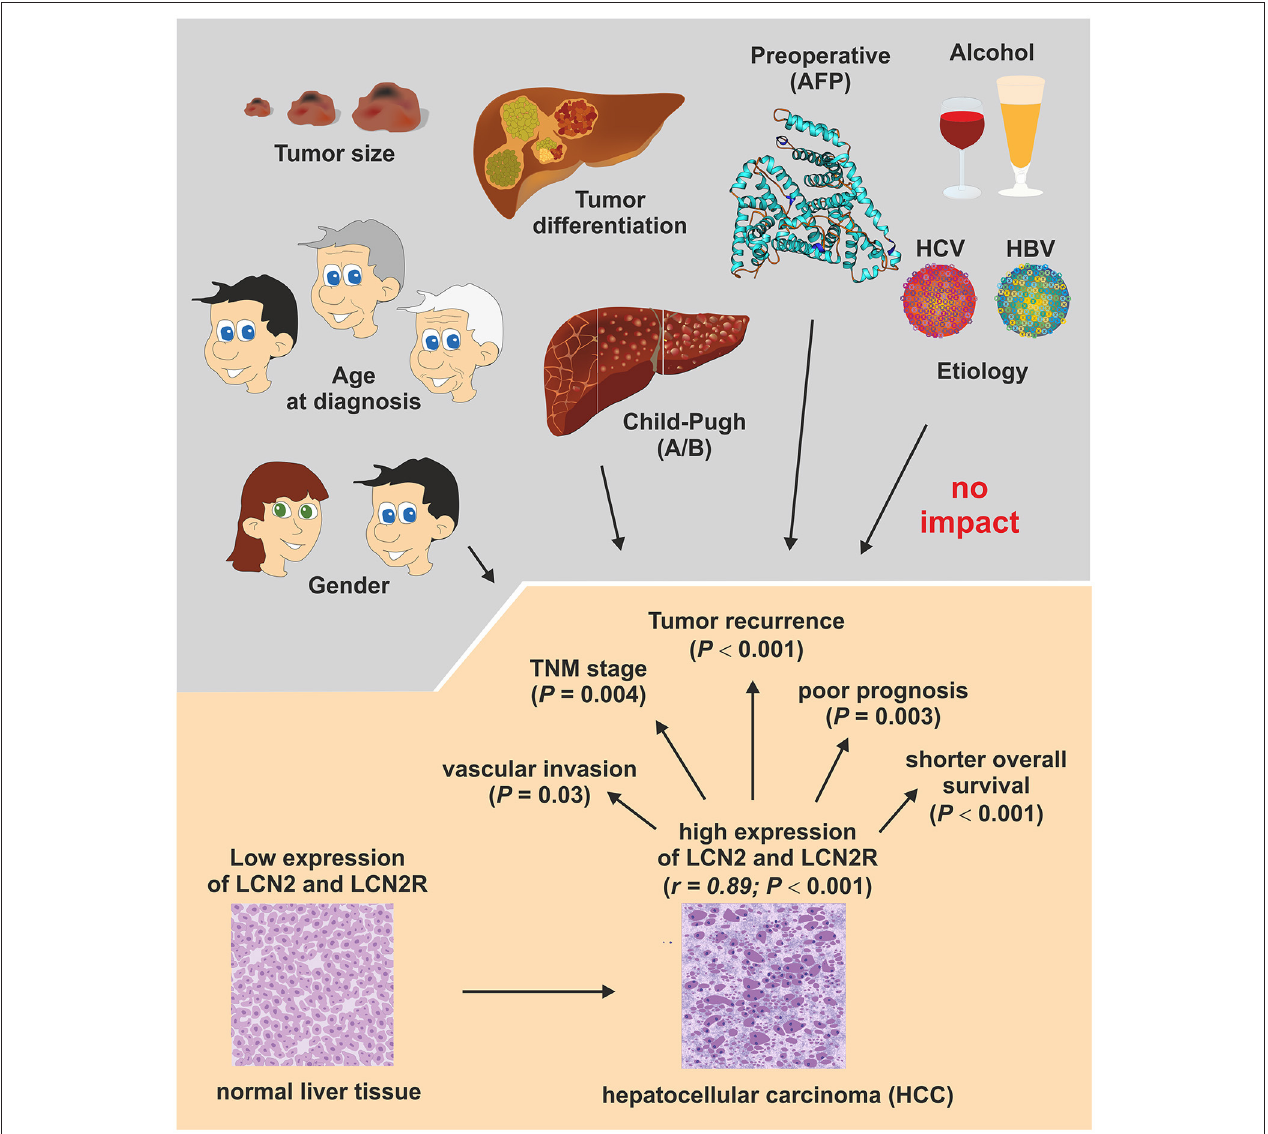
FIGURE 6 | Association of LCN2 and LCN2R expression with conventional clinicopathological HCC parameters. An association study investigated the clinical significance of LCN2 and LCN2R in 138 patients who underwent curative resection of HCC. In conclusion, this study showed that the expression of both genes is correlated ( r = 0.89; P < 0.001) and are up-regulated in HCC tissue and associated with vascular invasion status ( P = 0.03) and TNM classification stage of malignant tumors ( P = 0.004) that consider characteristics of the original primary tumor (T), the involved regional lymph nodes (N), and the occurrence of distant metastasis (M). In addition, the expression of both genes correlated well with tumor recurrence ( P < 0.001), poor prognosis ( P < 0.003), and overall survival rates ( P < 0.001), suggesting that LCN2 and LCN2R expression are suitable prognostic factors and potential therapeutic targets in HCC. Details of this study are given elsewhere (Zhang et al.,